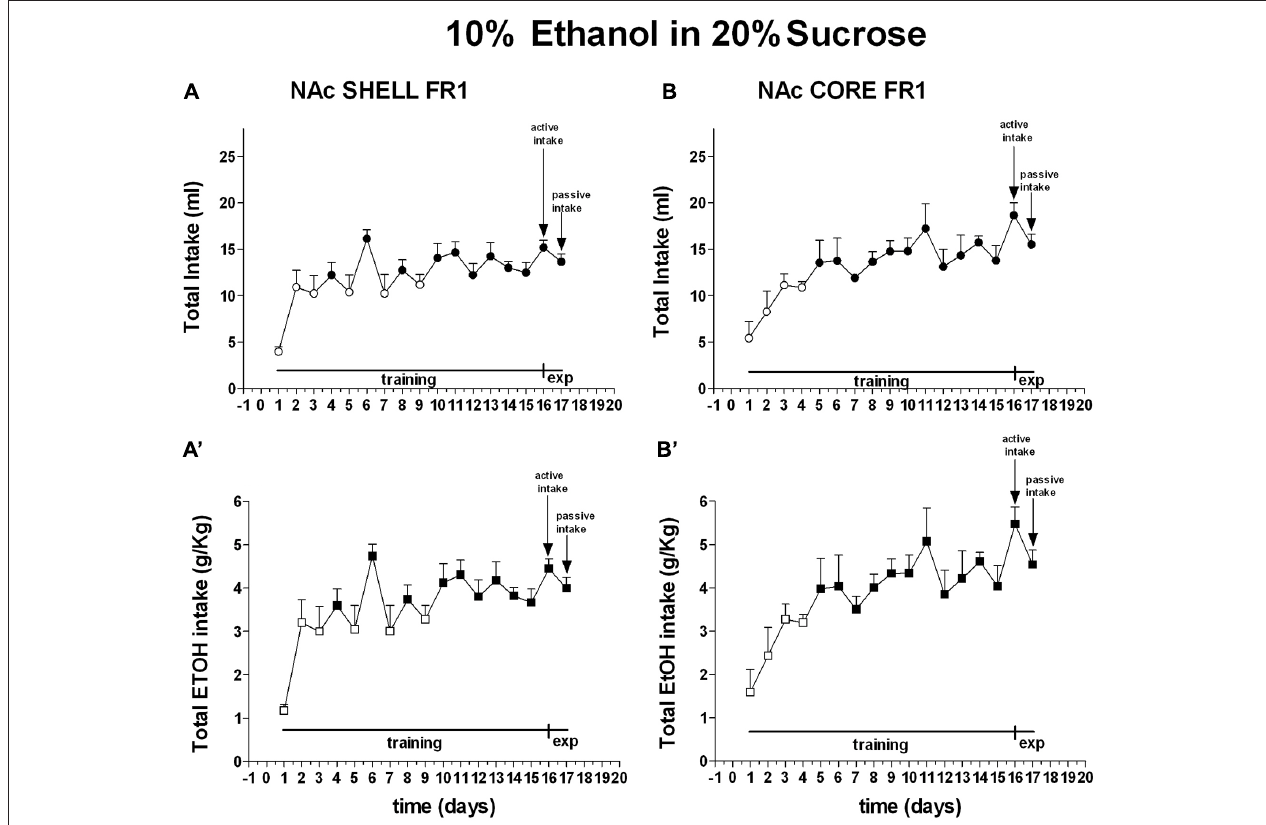
FIGURE 6 | Total intake expressed as ml of 10% ethanol in 20% sucrose solution and g/Kg of ethanol. Data are means ± SEM of the results obtained in rats implanted with guide cannulas in the NAc shell ( A :ml; A (cid:48) :g/Kg; N = 6) and rats in the NAc core ( B :ml; B (cid:48) :g/Kg; N = 6). Filled symbols, p < 0.05 vs. 1st